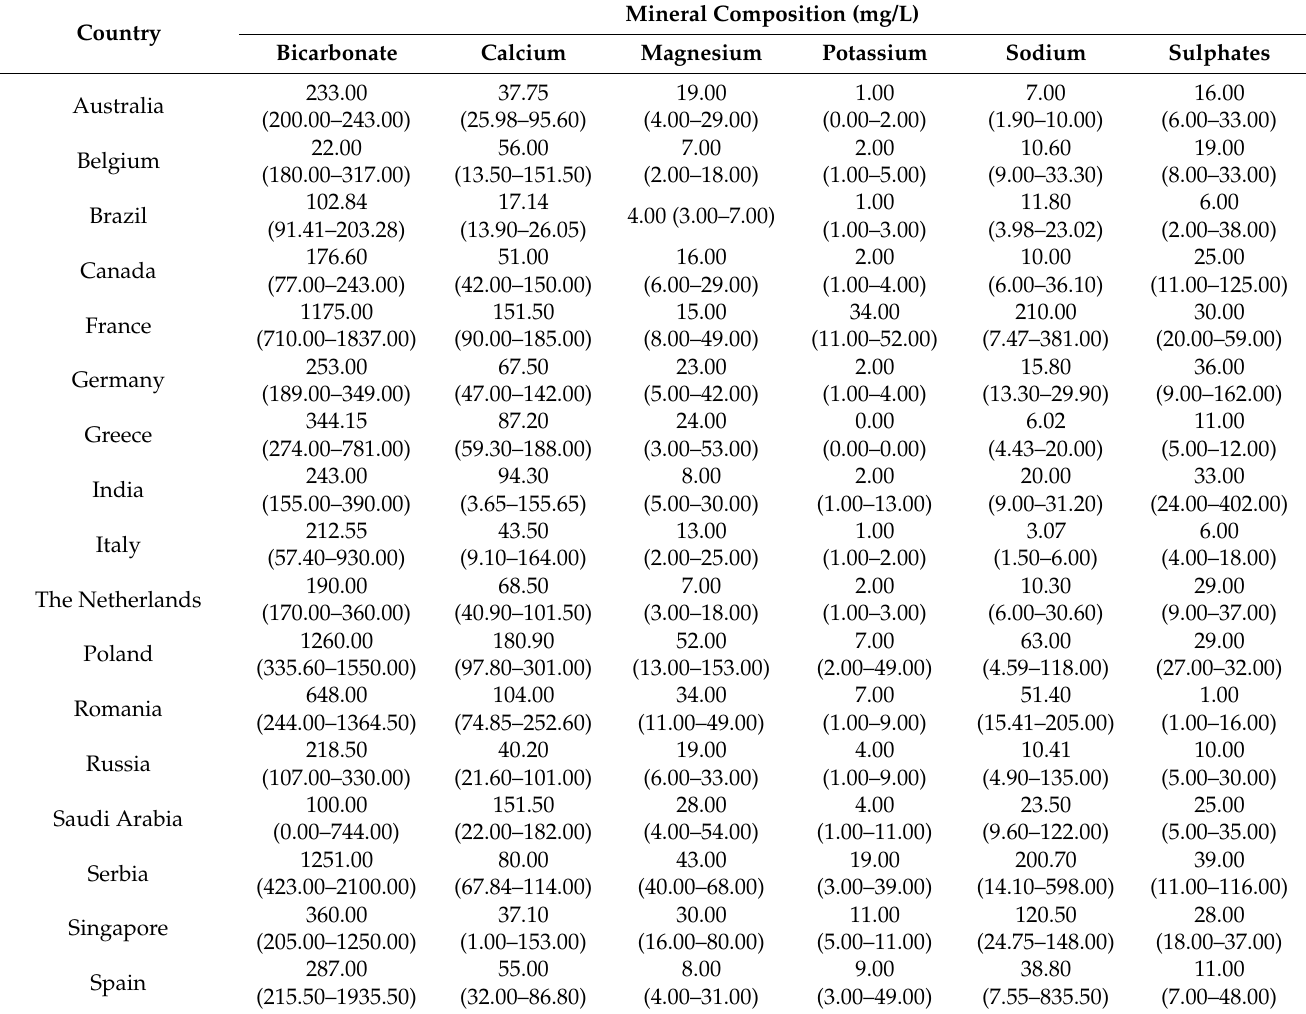
Table 2. The mineral composition (mg/L) of bottled sparkling water expressed as median